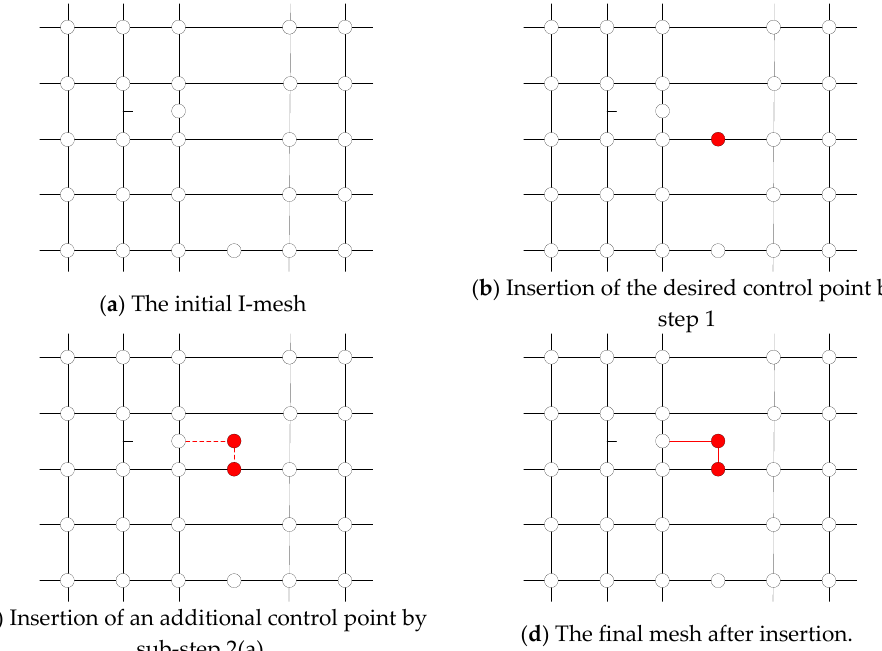
Figure 8. Control point insertion in a 2D I-spline topology.